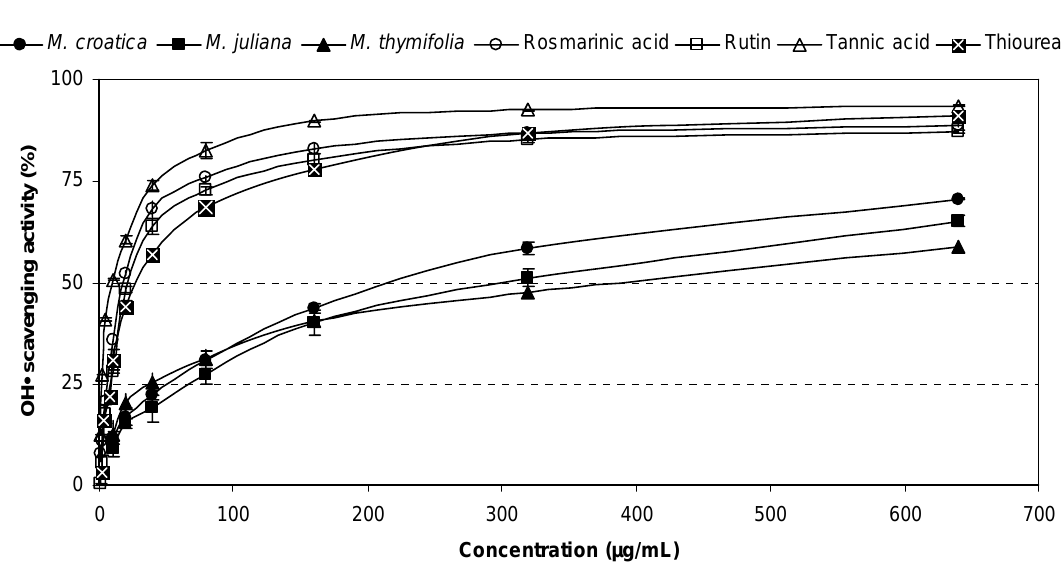
Figure 3. OH free radical scavenging effects of Micromeria ethanolic extracts in comparison with polyphenolic compounds and a reference